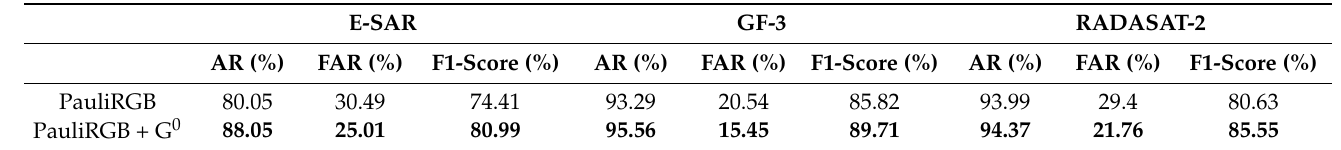
Table 4. Building extraction accuracy table using G 0 statistical texture parameters.